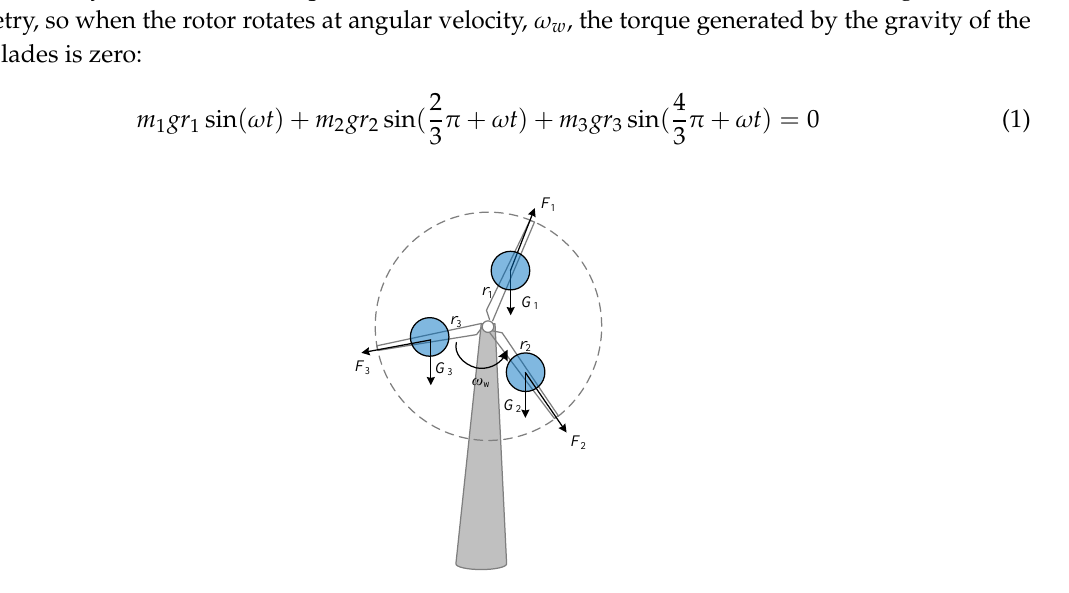
Figure 1. 3-bladed wind turbine schematic diagram.